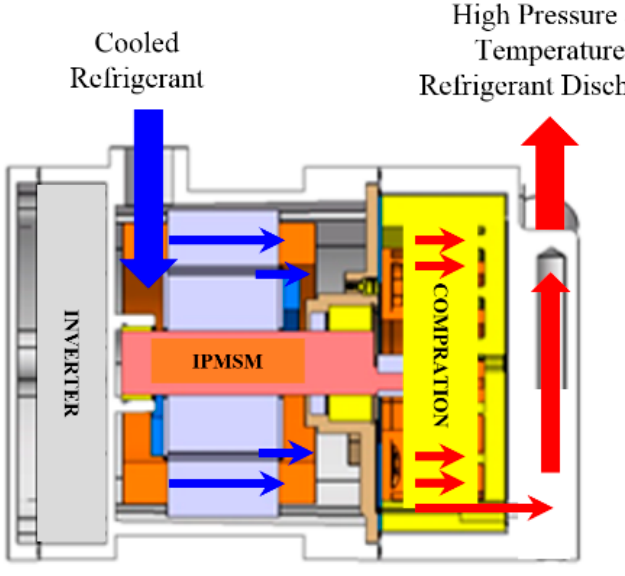
Figure 1. The schematic of the eco-friendly automotive AC refrigerant compressor.